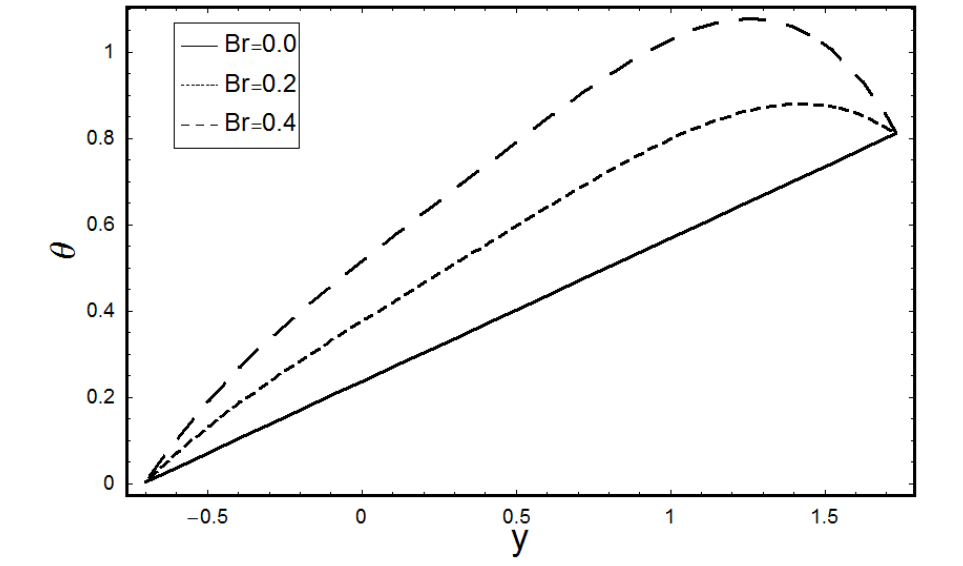
Figure 11. Variation in θ for Br with a = 0.3, b = 0.3, d = 0.6, φ = π /4, Θ = 1, x = 0, n = 1.5, b ∗ = 0.2, Bi 1 = 1 and Bi 2 =